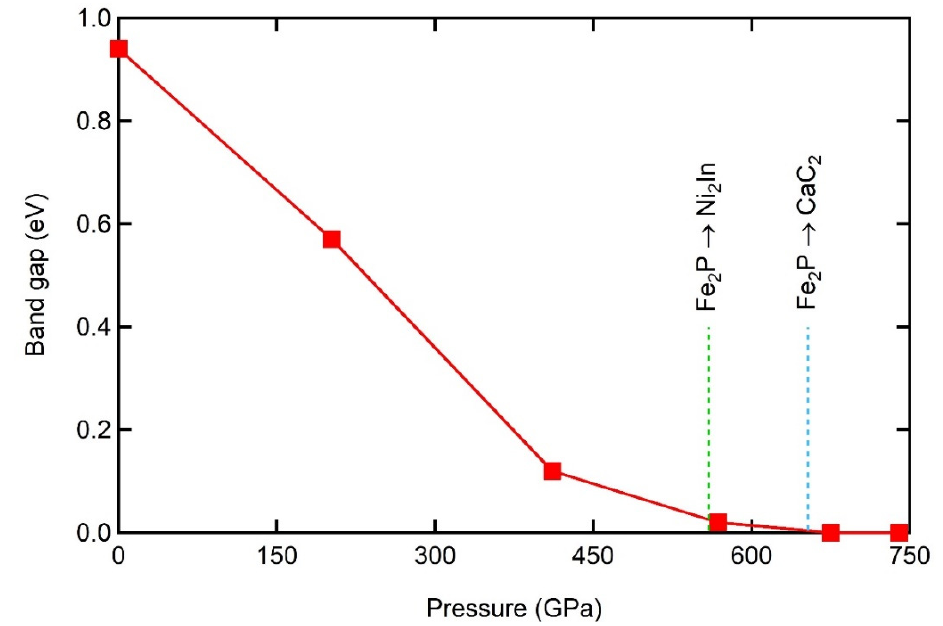
Figure 4. Calculated band gap of the Fe 2 P phase as a function of pressure. The vertical dashed lines indicate the transition pressures of the Fe 2 P → Ni 2 In and Fe 2 P → CaC 2